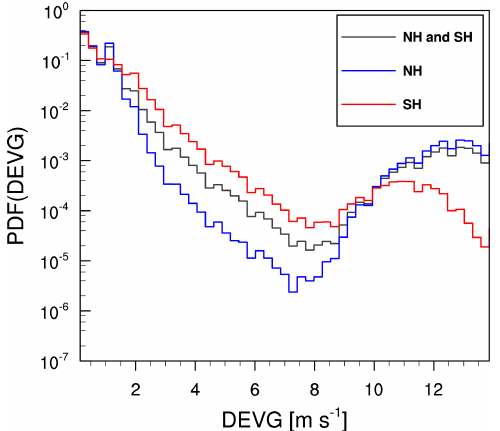
Figure 3. The probability density functions (PDFs) of the raw DEVG over the Northern Hemisphere (NH: blue line), the South- ern Hemisphere (SH: red line), and the globe (NH and SH: black line) at altitudes above 15kft ( ∼ 4 . 57km) from October 2015 to September